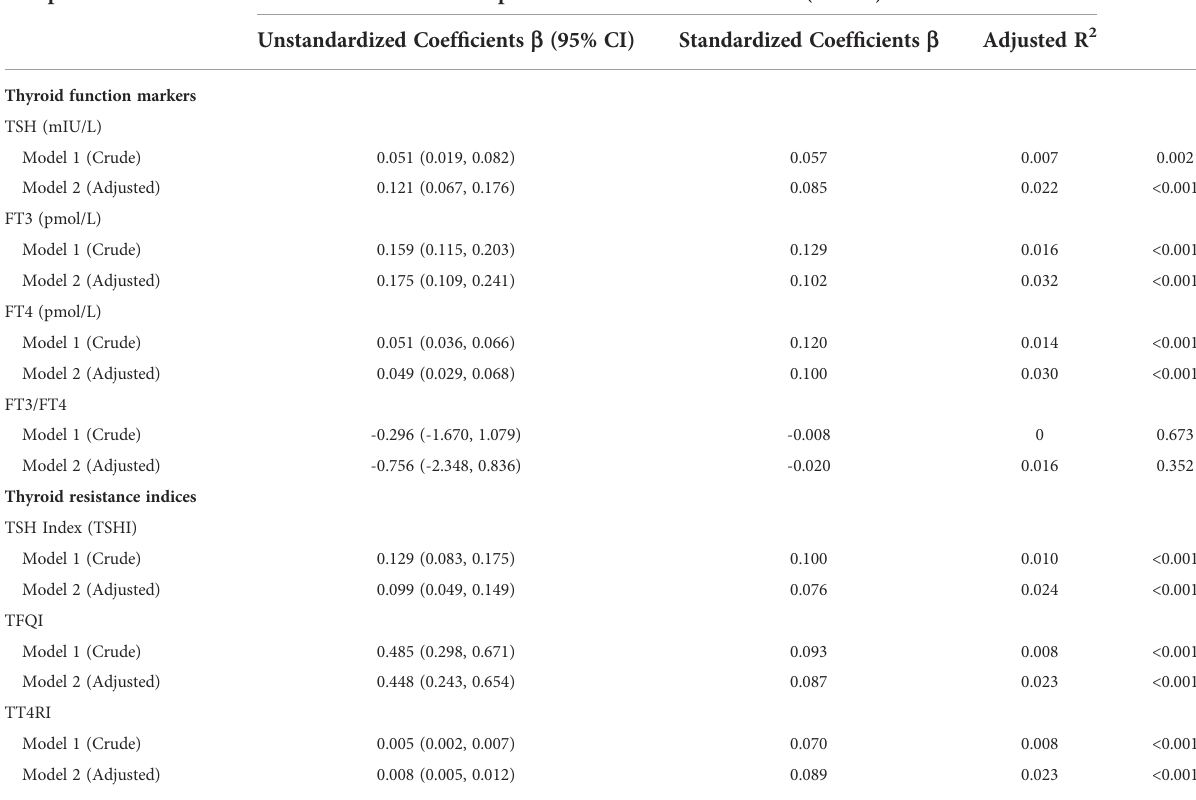
TABLE 2 Multivariable linear regression on the associations of maternal thyroid function and thyroid resistance indices with infantile TSH level, Huizhou mother-infant cohort (n = 3,210). Independent